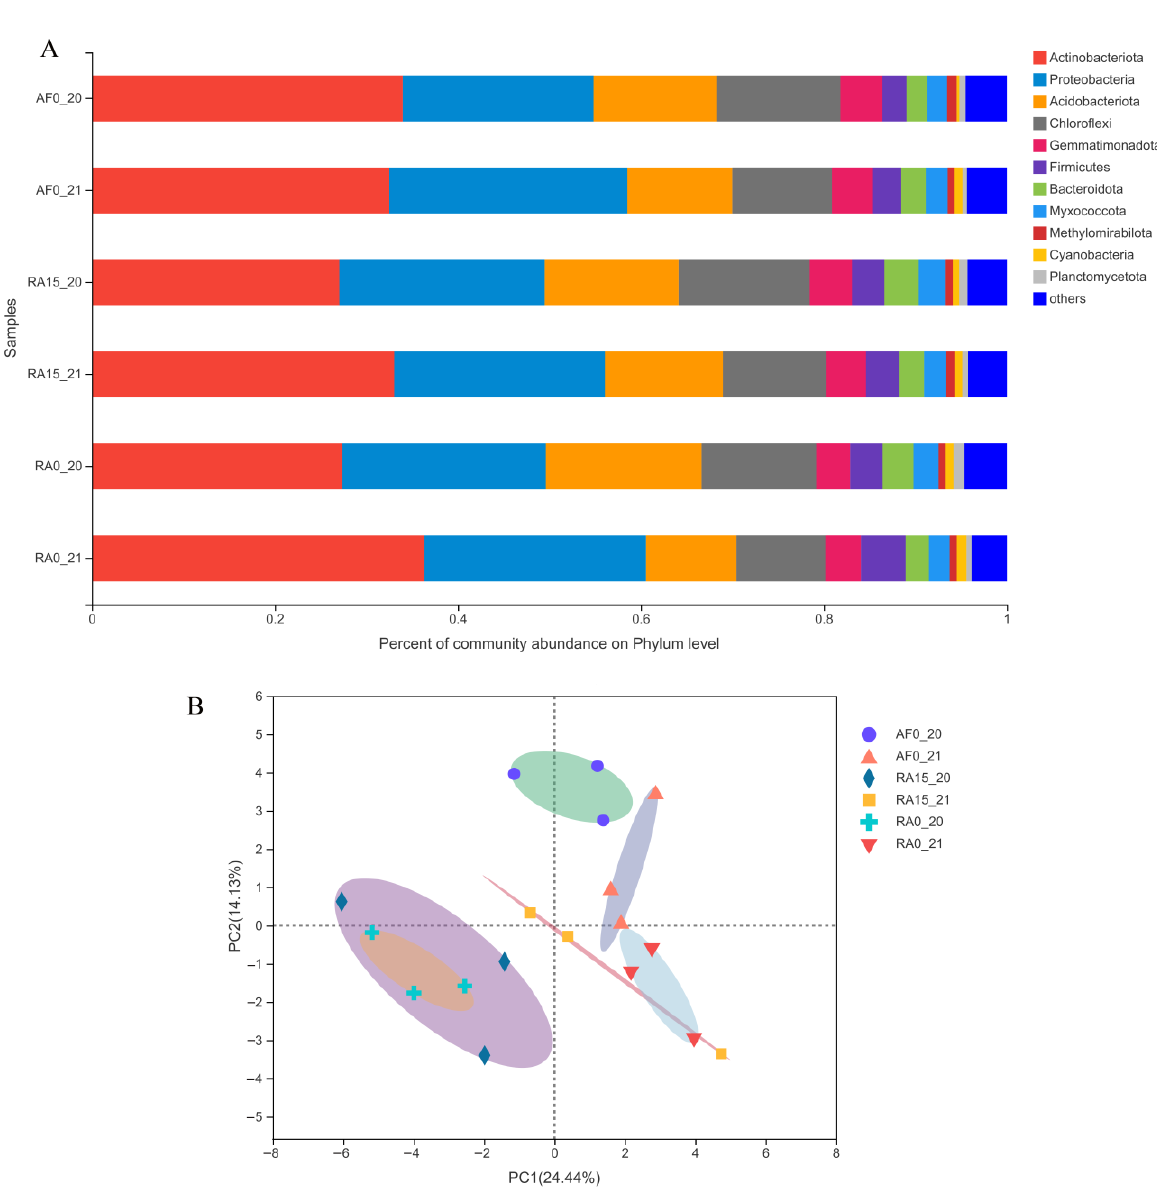
Figure 2. Dominant bacterial phyla ( A ) and principal component analysis (PCA) of the bacterial community ( B ).